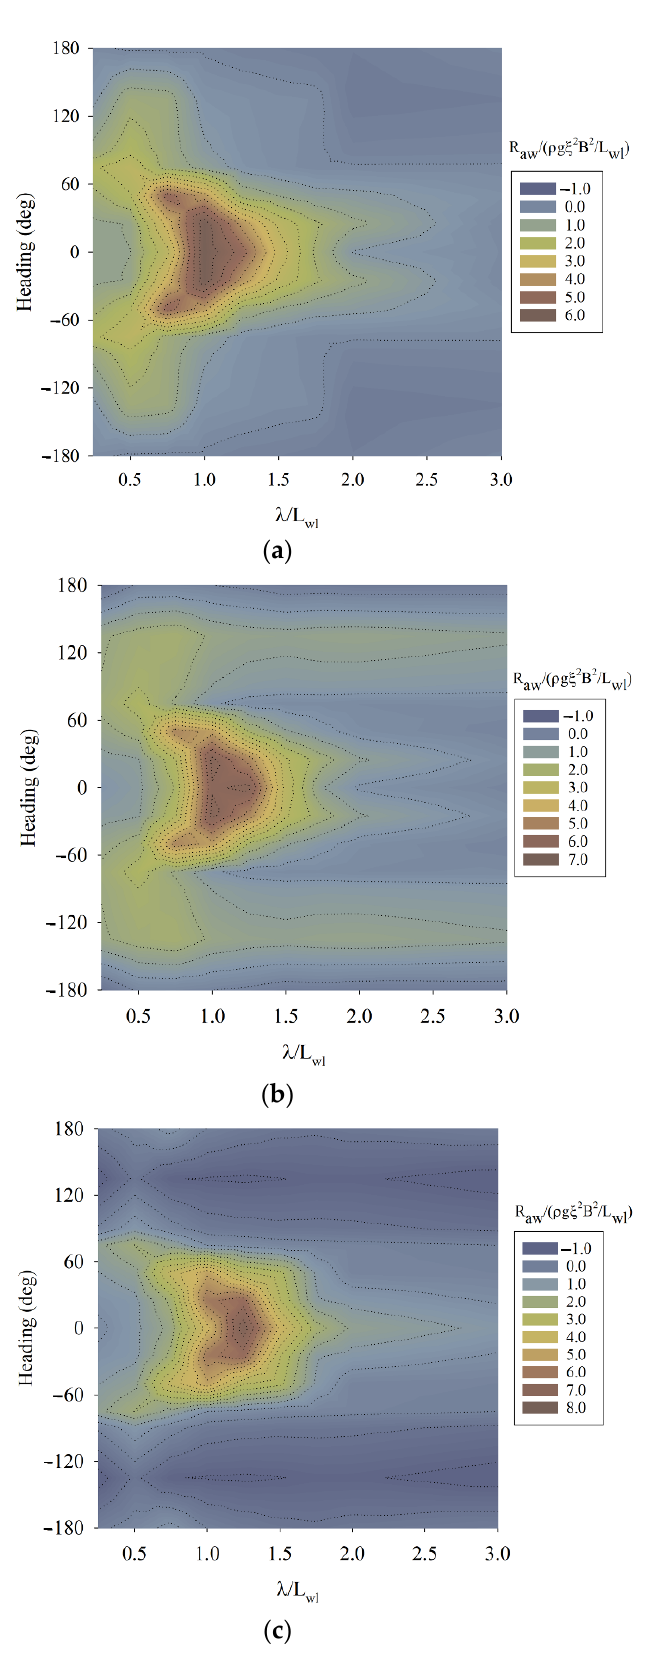
Figure 8. Dimensionless added wave resistance versus different wavelengths versus different wave headings in Load Condition 2. ( a ): Fr = 0.16. ( b ): Fr = 0.20. ( c ): Fr = 0.24. Source: Own elaboration.